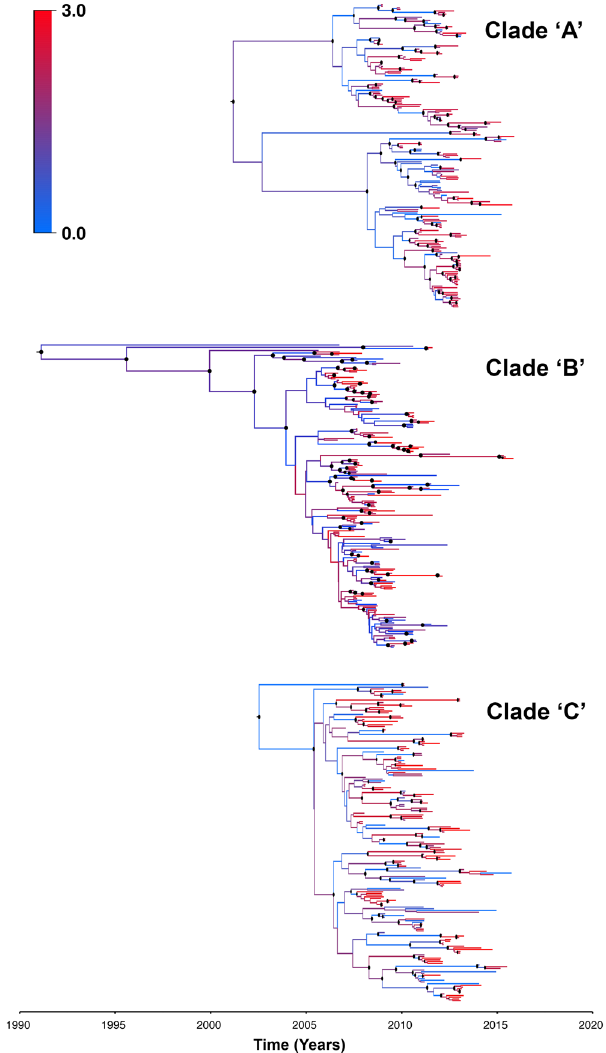
Figure 4. Maximum clade credibility (MCC) phylogeny of ORF-5 gene of PRRS clades ‘A’, ‘B’ and ‘C’ viruses in the Midwest estimated under the best-fitting spatial diffusion model (Table 2). The color of the branches represents the among-branch spatial diffusion rate variation and corresponds to the color gradient legend on the middle right. Well-supported posterior probabilities (P > 0.85) of branching events are indicated by black circles at the